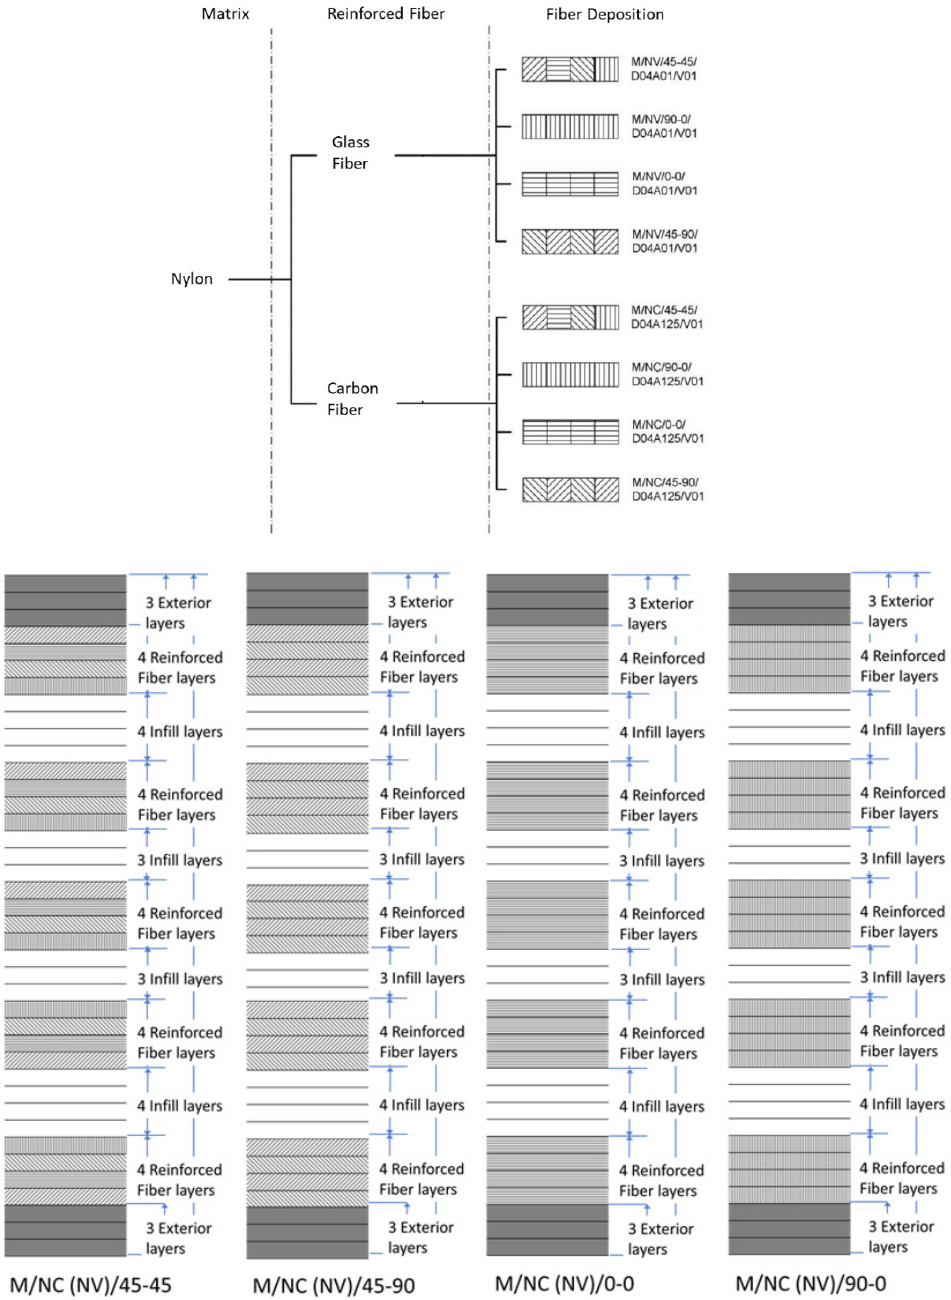
Figure 4. Markforged fiber deposition patterns (above) and layer distribution (below).